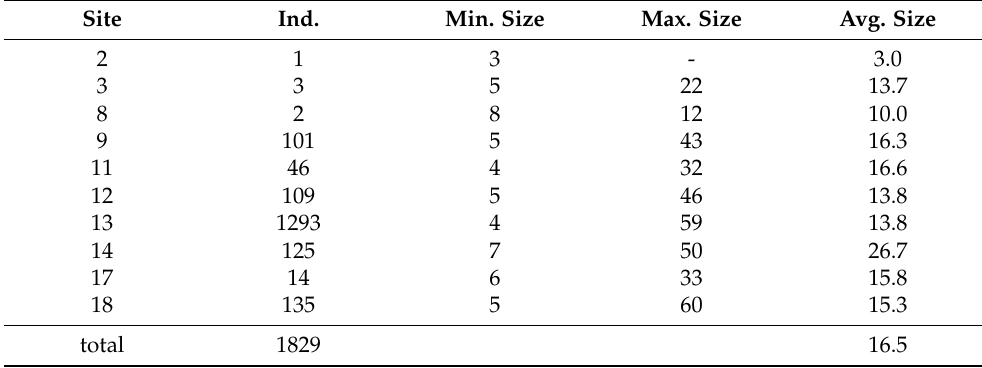
Table 5. Sampling results of the trawl survey in the East China Sea. Site